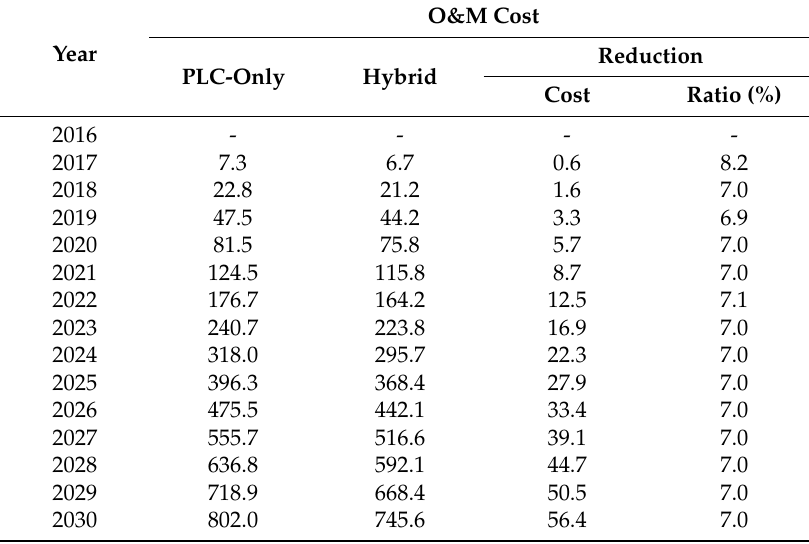
Table 6. Comparison of O&M Cost Result per Deployment Method (Billion